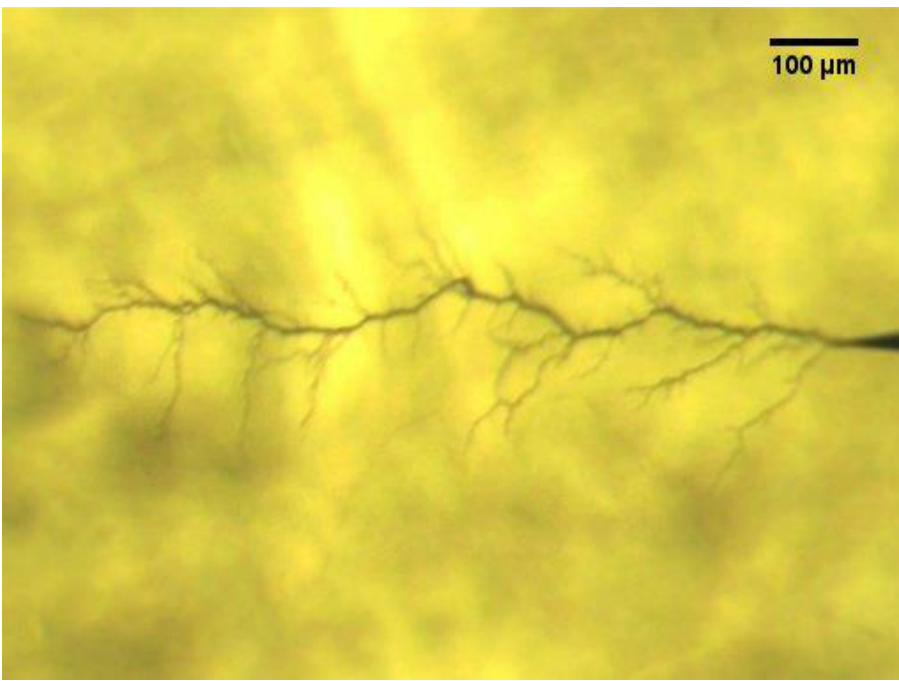
Figure 9. Electrical tree developed at negative voltage with firing angle of 60 degrees.